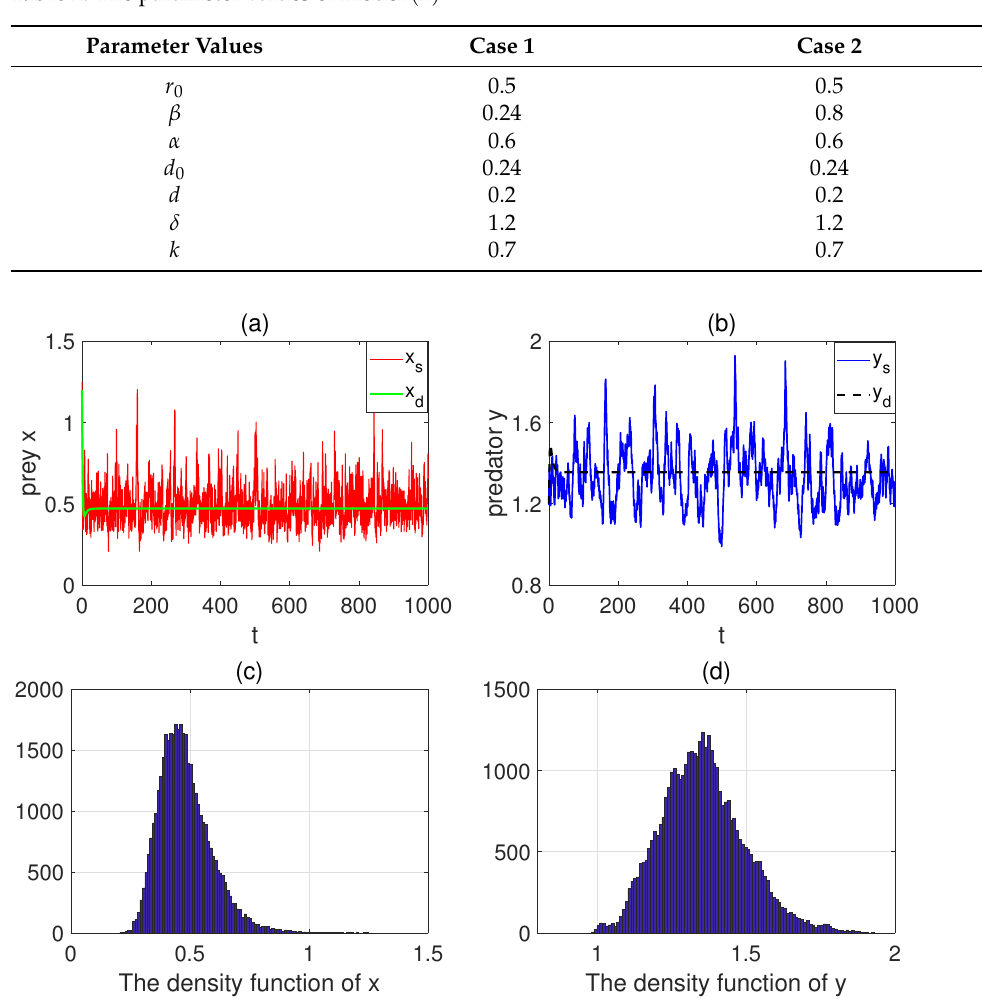
Table 2. The parameter values of model ( 2 ) .